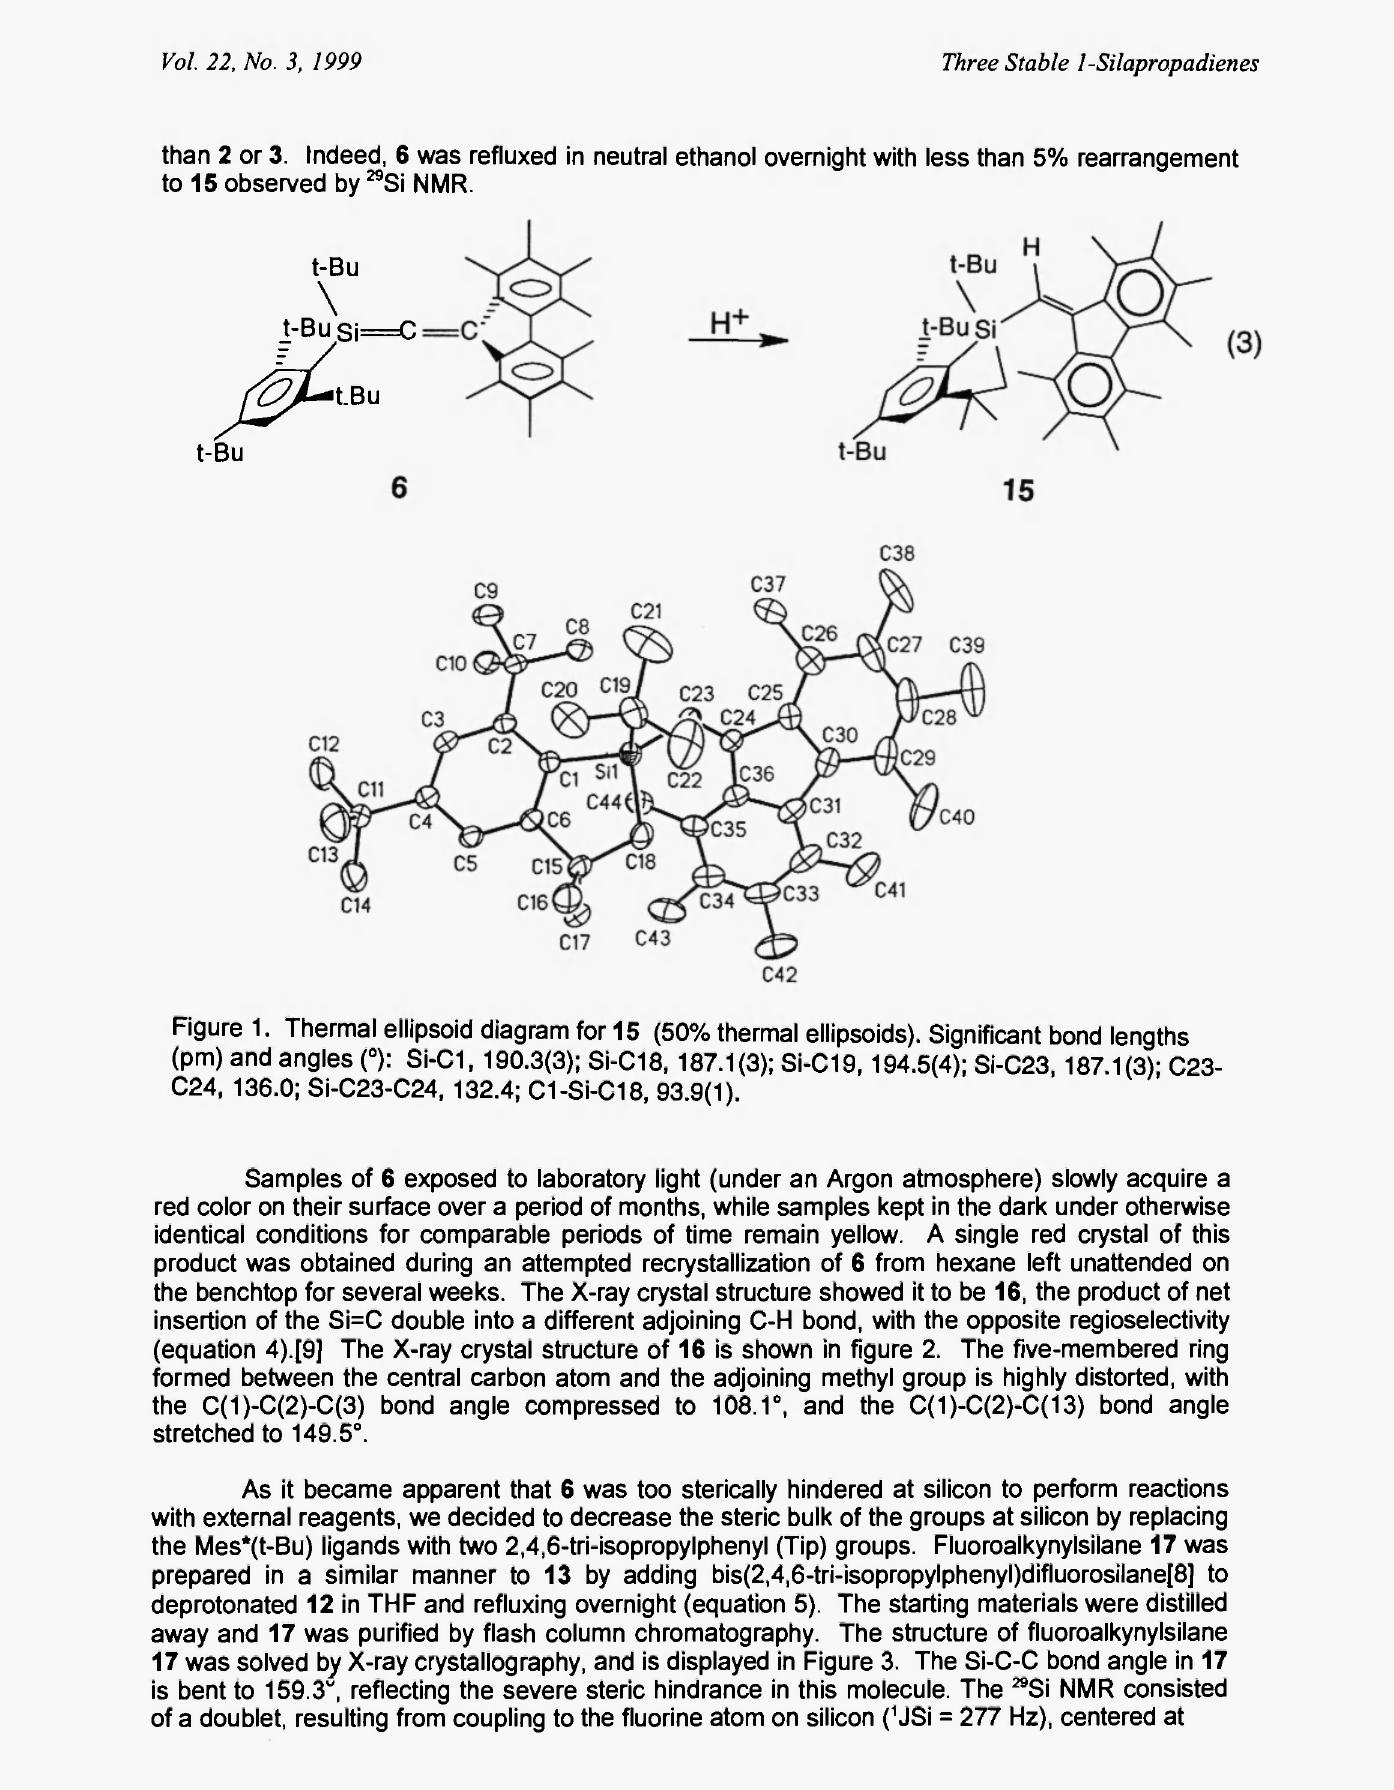
Figure 1. Thermal ellipsoid diagram for 15 (50% thermal ellipsoids). Significant bond lengths (pm) and angles (°): Si-C1, 190.3(3); Si-C18, 187.1(3); Si-C19,194.5(4); Si-C23, 187.1(3); C23- C24, 136.0; Si-C23-C24, 132.4; C1-Si-C18,